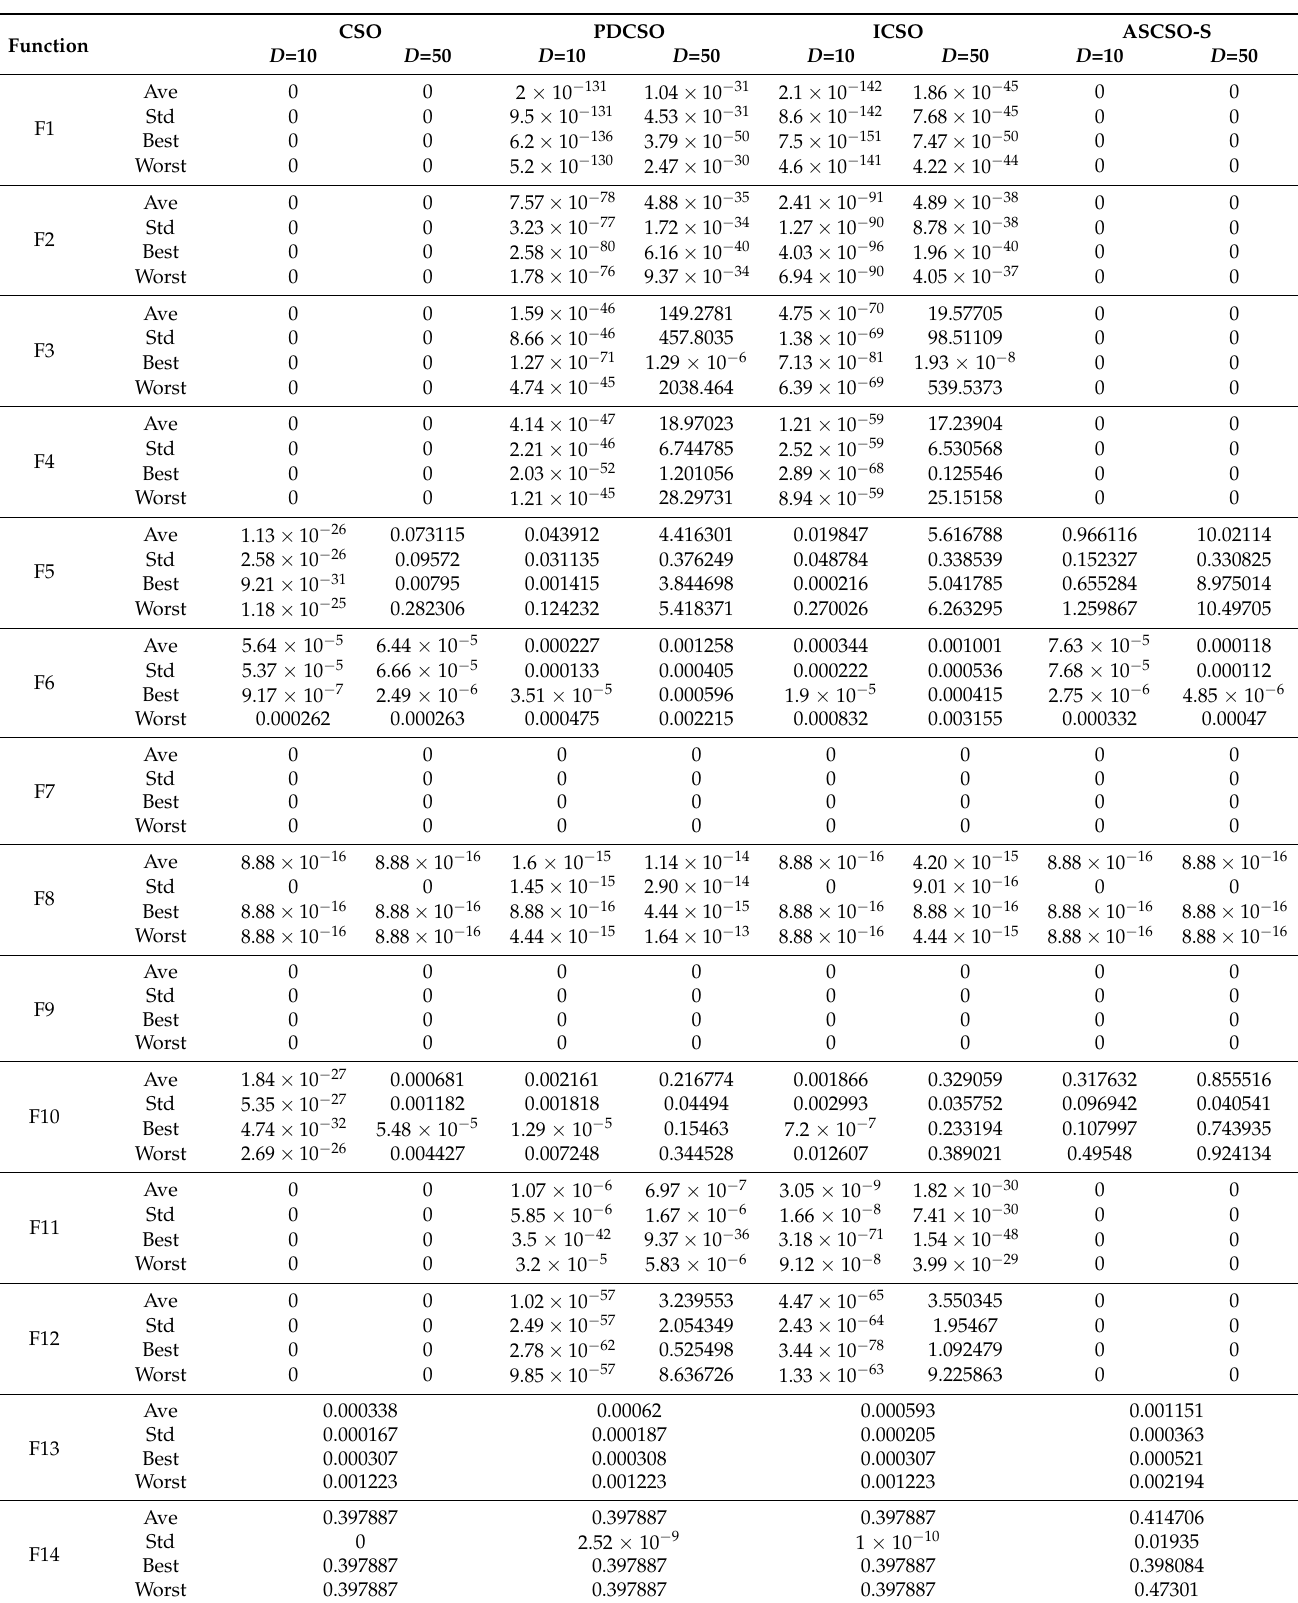
Table 3. Test results for different improved